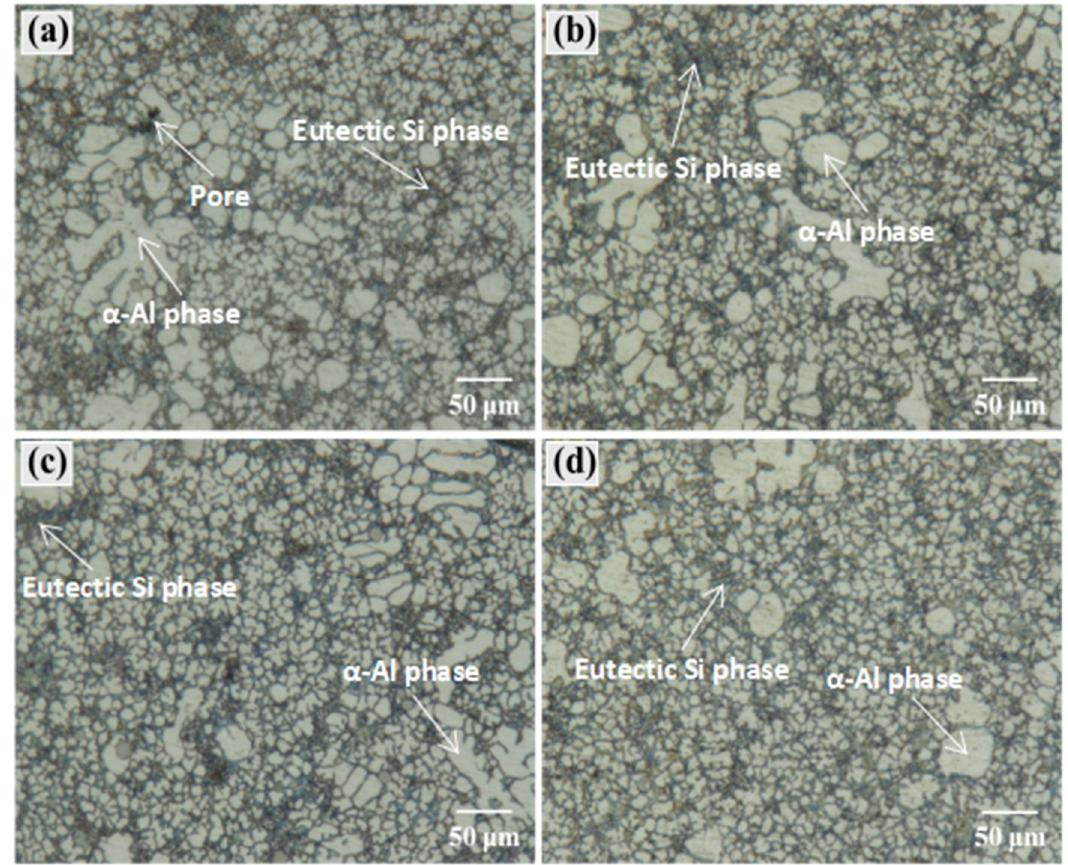
Figure 9. Microstructure of thin-walled area at different boost pressures: ( a ) 700 bar, ( b ) 750 bar, ( c ) 800 bar, ( d ) 850 bar.